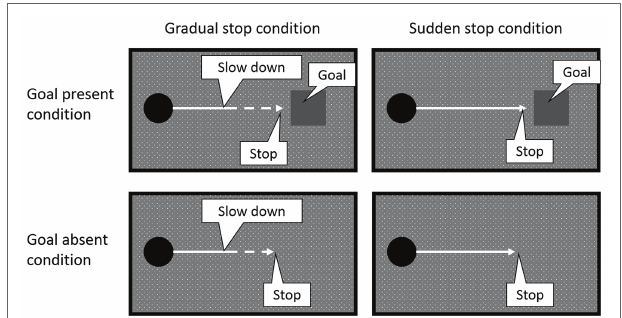
FIGURE 1 | Examples of motion of a circle in four experimental tasks. These four conditions were blocked. Solid lines indicate constant velocity motion, and dashed lines indicate slowing down. On most trials (75% of trials in each block), the circle stopped automatically. Participants were asked to press a key on every